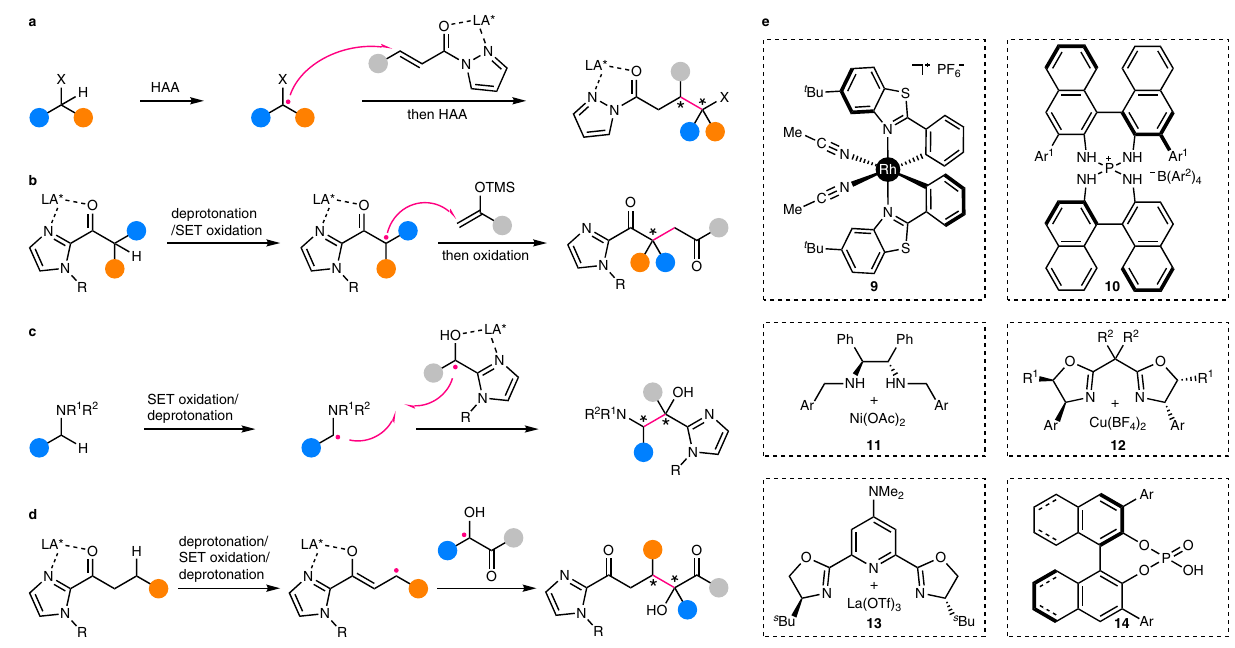
Fig. 5 Examples of enantiocontrol by chiral Lewis/Brønsted acid catalysts in enantioselective C( sp 3 ) – H functionalization. a Enantioselective addition of C – H-derived free achiral/prochiral radicals to chiral Lewis acid-coordinated π -acceptors. b Enantioselective addition of C – H-derived chiral Lewis acid- coordinated prochiral radicals to free π -acceptors. c Enantioselective coupling of C – H-derived free achiral/prochiral radicals with chiral Lewis acid- coordinated radicals. d Enantioselective coupling of C – H-derived chiral Lewis acid-coordinated prochiral radicals with free radicals. e Structures of typical Lewis and Brønsted acid catalysts employed in relevant works. LA* chiral Lewis